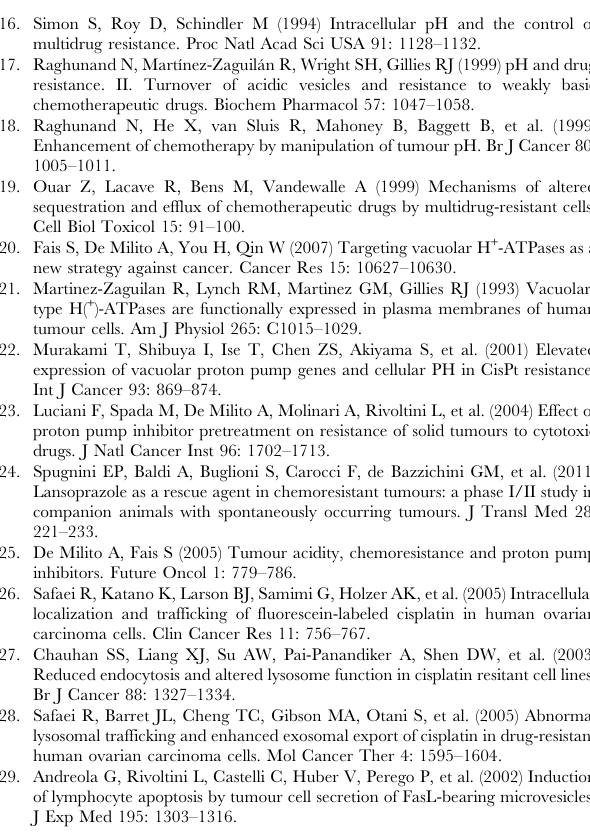
Figure S2 Cytotoxicity assay by Trypan blue exclusion method. MCF7 and Me30966 cells were treated with CisPt for 24, 48 and 72 hours. (TIF) Figure S3 Cytotoxicity assay by Trypan blue exclusion method. PBMC resting were incubated for 24 and 48 h at pH 7.4, UNB and pH 6.0 conditions. (TIF) Table S1 Instrument settings and data acquisition parameters for Q-ICP-MS. Table S2 HPLC-Q-ICP-MS operative conditions of the method. Table S3 Limits of quantification (LoQs) of CisPt and intra-day precision (CV %) in cells and